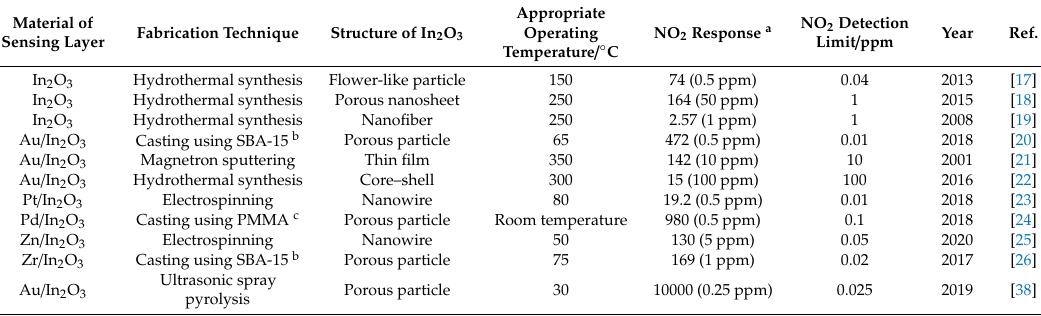
Table 1. Typical examples of NO 2 detection using In 2 O 3 -based gas